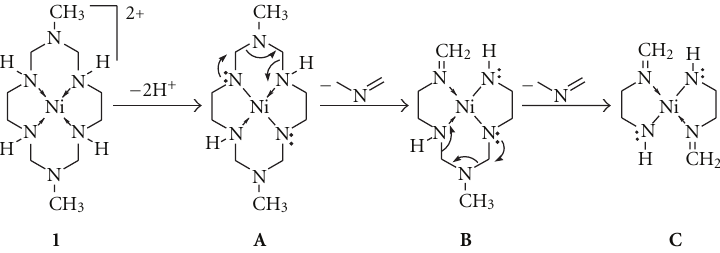
Scheme 1: The fragmentation pathway of the cationic complex 1 inside the charged